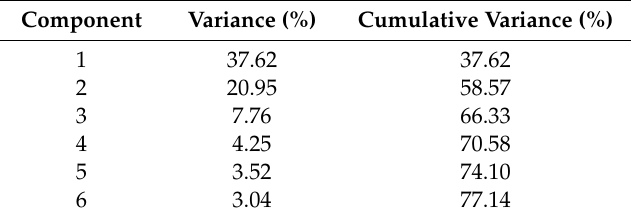
Table 2. Percentage of variance explained by the first six rotated principle components for SPI-12. Component Variance (%) Cumulative Variance